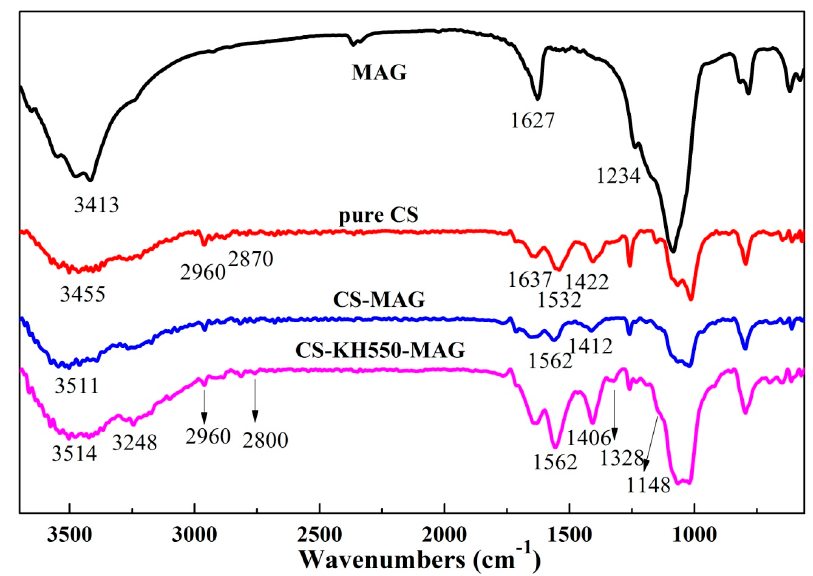
Figure 4. Fourier transforms infrared spectroscopy (FTIR) spectra of CS/MAG and CS/KH550/MAG hybrid membranes.